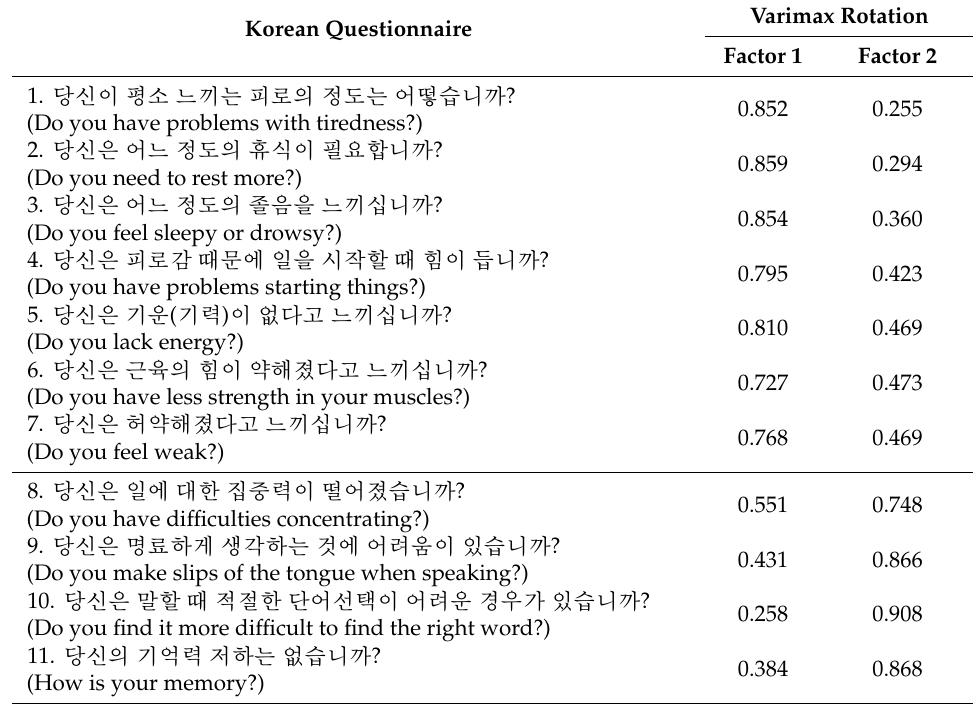
Table 1. The mKCFQ11 and its component